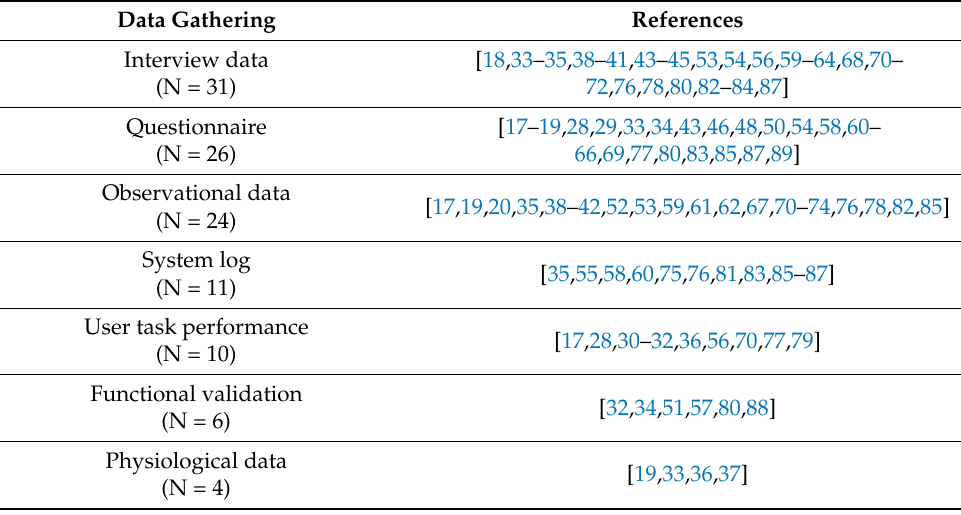
Table 2. Types of data gathering (“N” stands for the number of